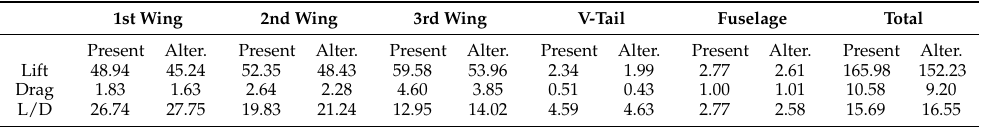
Table 6. BWA/SL aircraft in cruise flight condition S 3 (M = 0.7 at 43,000 ft) with an angle-of-attack α = 0°. Breakdown of lift and drag forces (in tons) and their ratio, with comparison against the alternative calculation (“alter.” label).